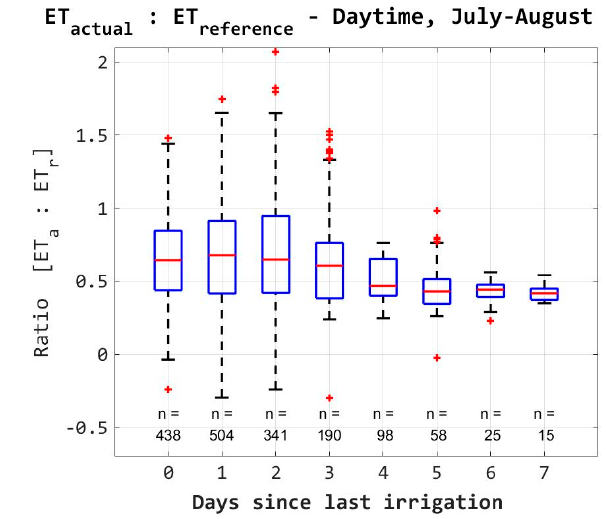
Figure 8. Average of ratio of 30-minute ET a :ET ref , grouped by the number of days since last irrigation (at site 1). Boxes indicate the 1st to 3rd quartile range (25th–75th percentile), with the median value indicated by the red line. Whiskers bound the most extreme values within ± 2.7 σ , with outliers outside these bounds indicated by “+”